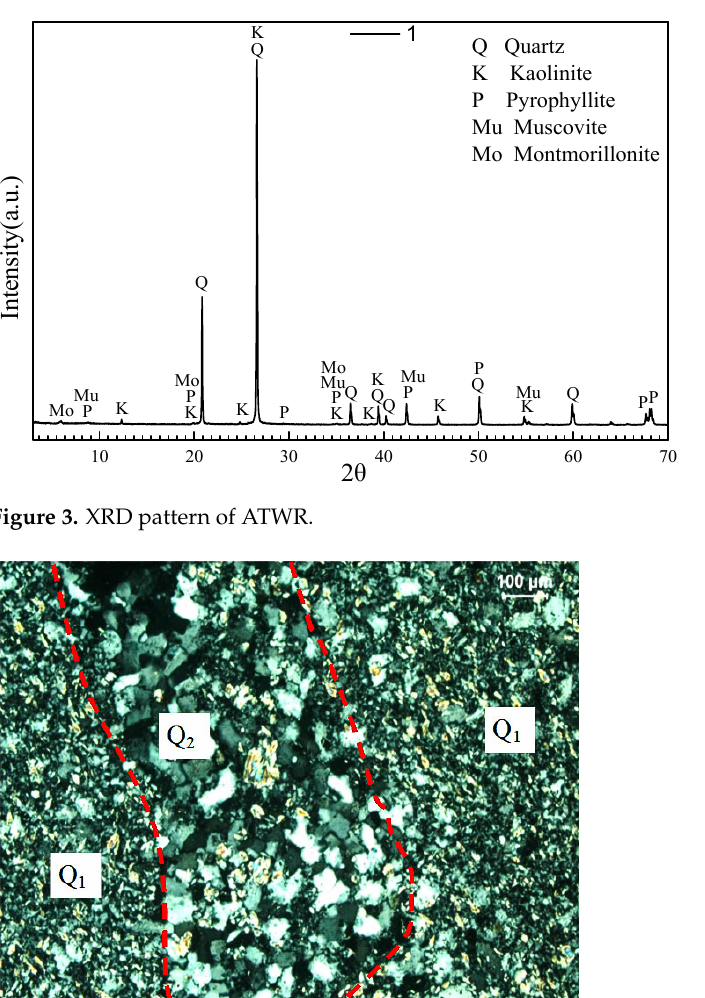
Figure 4. Mineral composition of ATWR. (Q 1 represents the early stage of quartz, and Q 2 represents the late stage of quartz.)